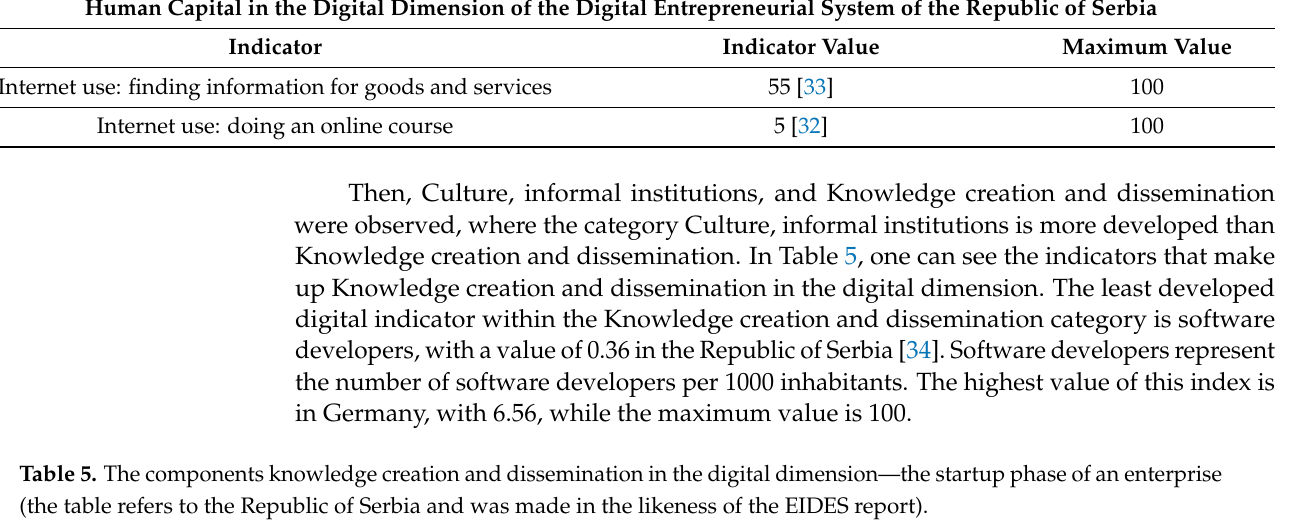
Table 4. The components of human capital in the digital dimension—the scale-up phase of an enterprise (the table refers to the Republic of Serbia and was made in the likeness of the EIDES report).